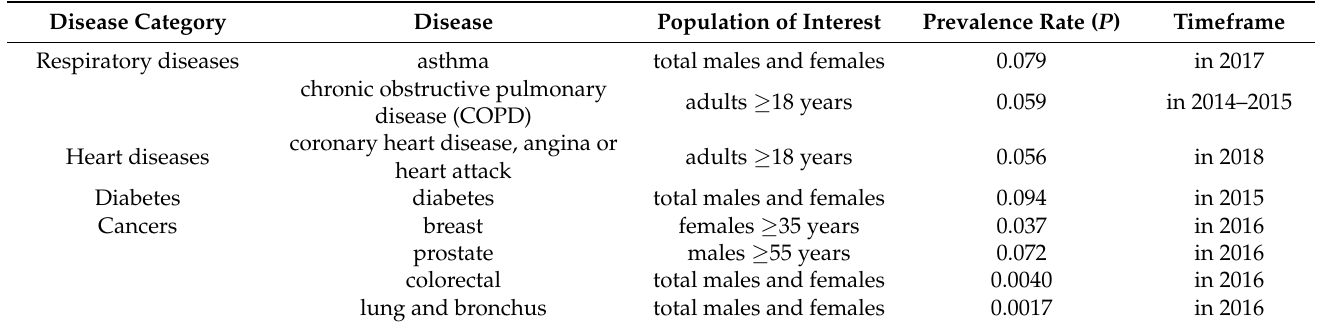
Table 1. Estimates of prevalence for common chronic diseases of interest in United States. Disease